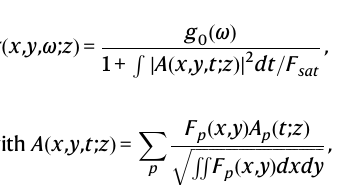
patterns(rightinsets).Leftinsetof( a )showstheclose-upofthespectralevolution. c , d Corresponding evolutions of the two 3D multi-soliton molecules in the inter- action plane. e , f Projections of ( c ) and ( d